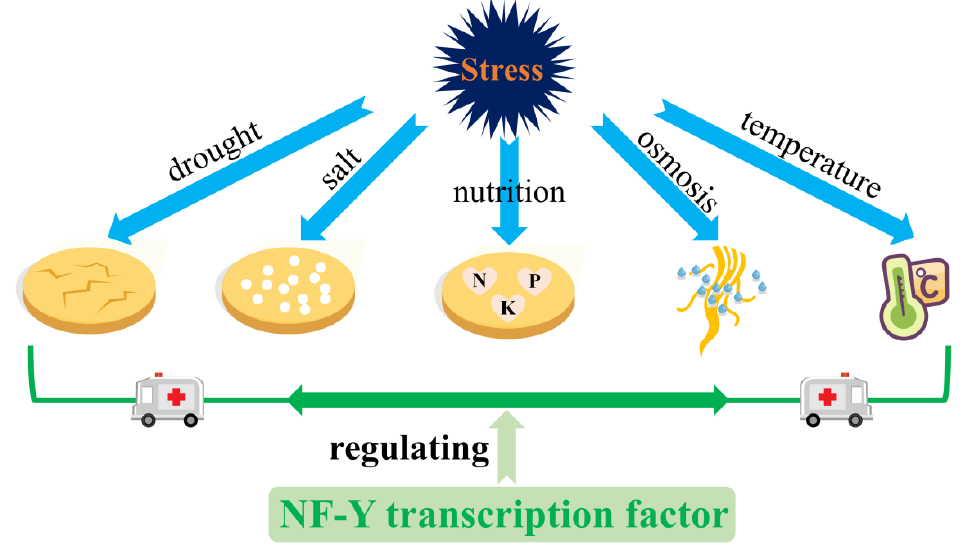
Figure 1. NF-Y transcription factors respond to abiotic stress.